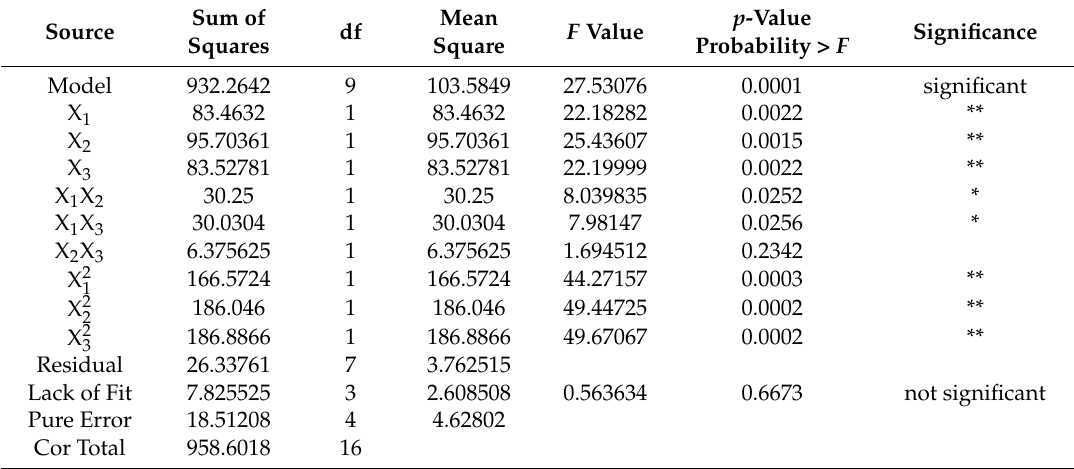
Table 2. Results of analysis of variance (ANOVA).